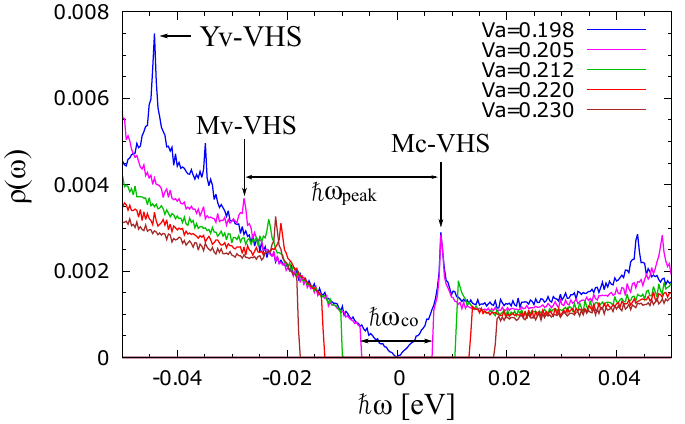
Figure 3. The density of states ρ ( ω ) for V a = 0.198,0.205,0.212,0.220,0.230. The origin of the peak structure in the optical conductivity is identified.